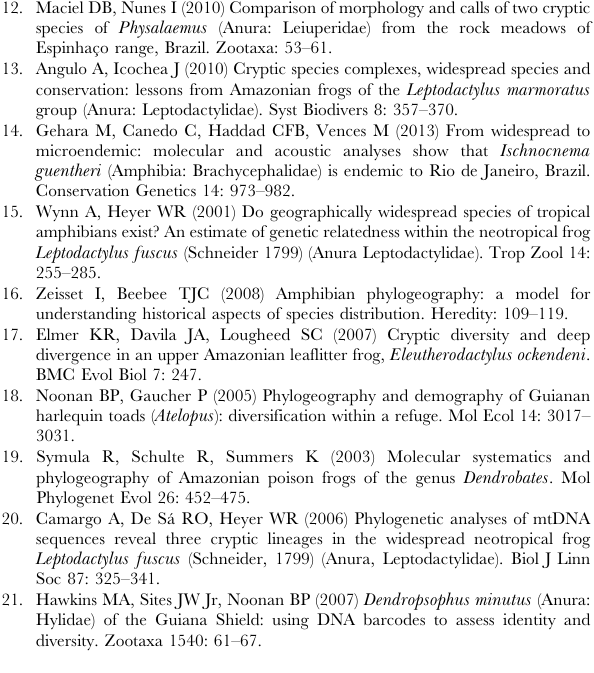
Figure S4 Spatial distribution models used as resis- tance layers in the Circuit Scape analysis. Figure S5 Distribution of all mitochondrial lineages. Map showing the distribution of all mitochondrial lineages in the Dendropsophus minutus group as revealed by this study. Symbols refer to those used in Figs. 1–3. Table S1 Complete data collection with genbank acces- sion numbers, voucher numbers and locality informa-